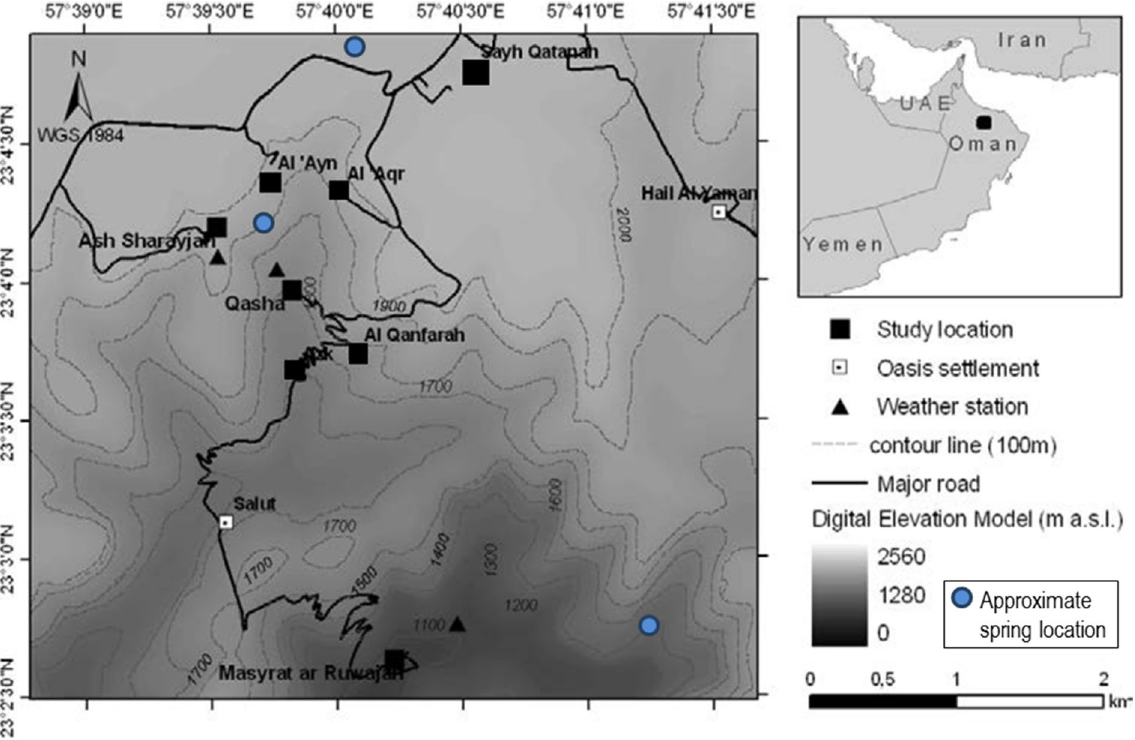
Figure 2. Digital elevation model of the study area on Al Jabal Al Akhdar (N-Oman; modified after Al-Rawahi et al. 3